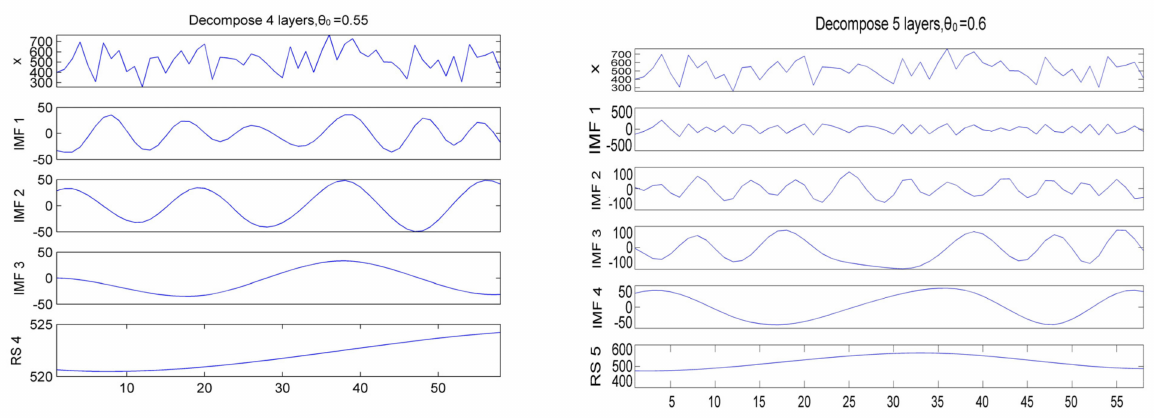
Figure 4. Results of MEEMD decomposition of summer precipitation in the Wujiang River